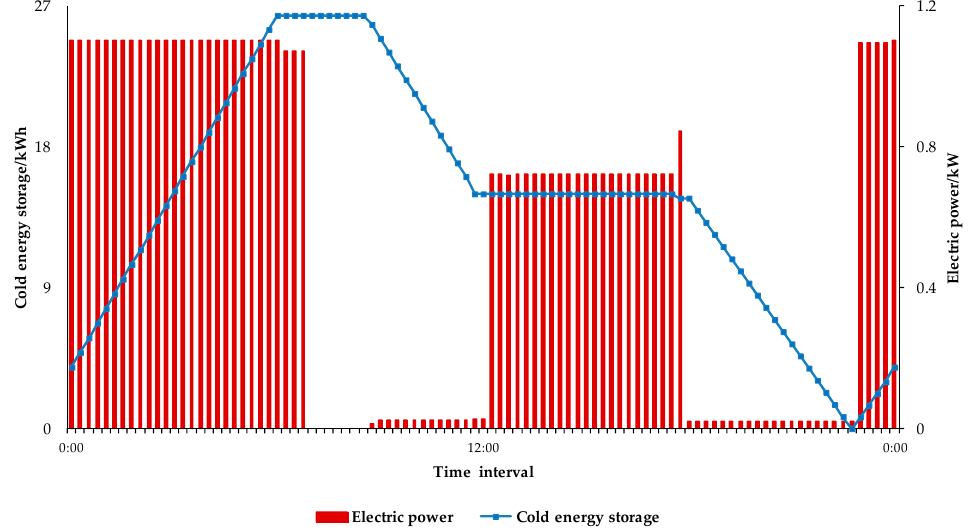
Figure 4. Electrical power demand and cold energy storage of a typical CSACS.